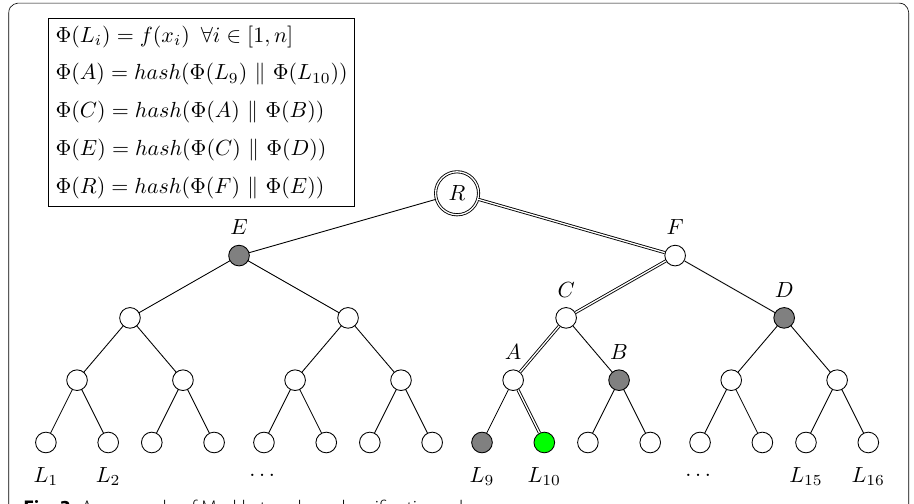
Fig. 3 An example of Merkle tree-based verification